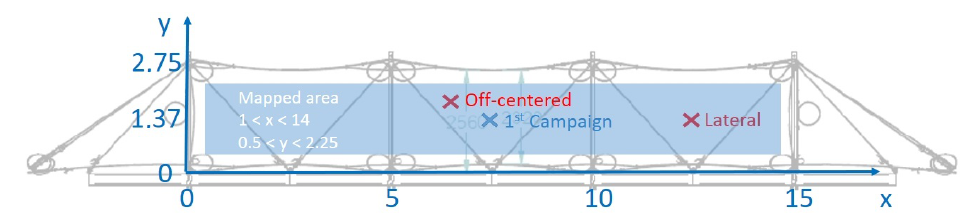
Figure 4. Location of impacts in the two experimental campaign, as well as zone mapped by the numerical simulations (a margin of 0.5 m (resp. 1 m) was taken along the long edges (resp. lateral edges) to avoid direct interaction of the block with edge cables).